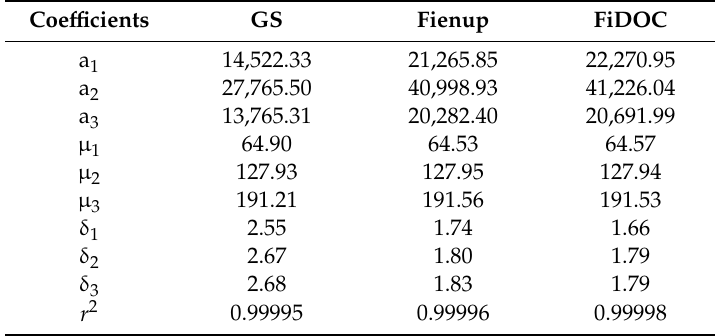
Figure 5. Distributions of grey values in the images reconstructed from holograms calculated by ( a ) GS algorithm; ( b ) Fienup algorithm; and ( c ) FiDOC algorithm, after 200 iterations. Table 2. The fitted values in the grey value distribution models for the images reconstructed from phase-only holograms calculated by GS, Fienup and FiDOC algorithms after 200 iterations.